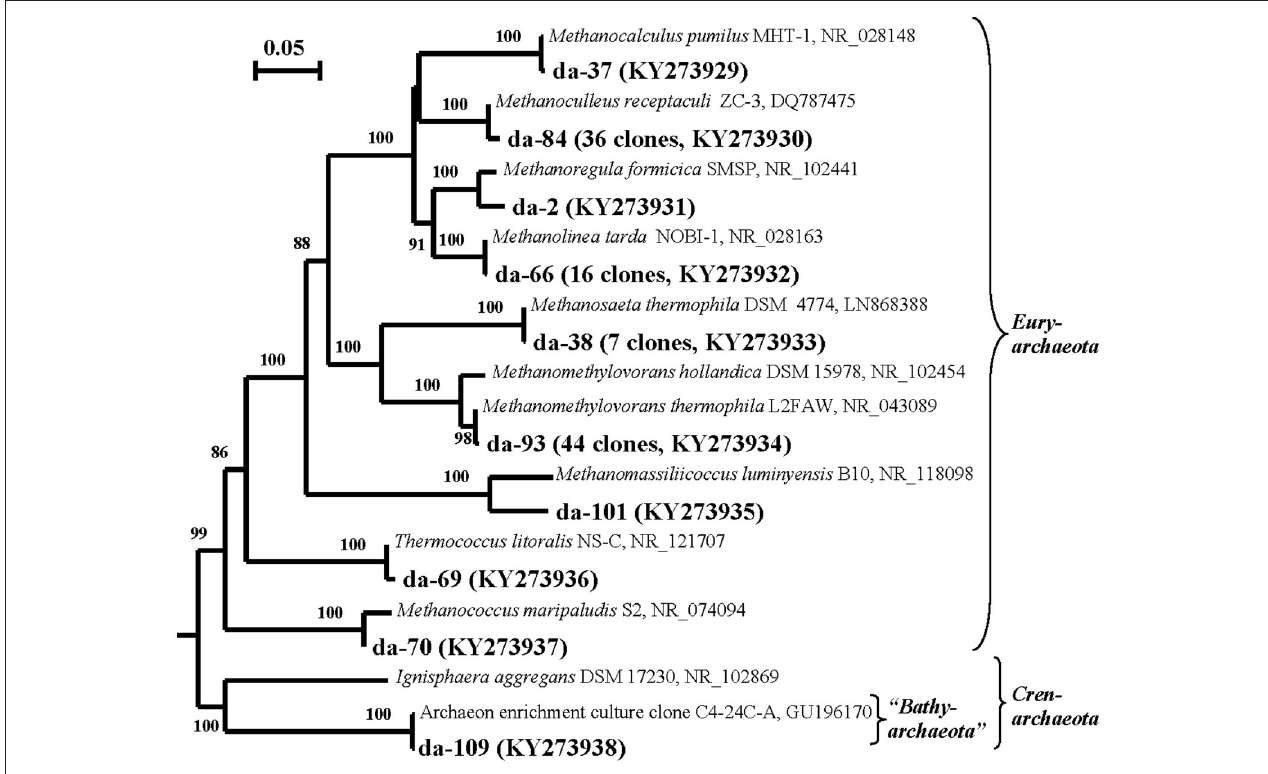
FIGURE 2 | Phylogenetic neighbor-joining tree constructed on the basis of analysis of the 16S rRNA gene sequences of Archaea revealed in the DNA-derived clone library of formation water from near-bottom zone of injection well 1098-8 m 3 sampled in December 2006 from the Kongdian bed. Designation: DA means DNA-based library of Archaea clones (115 clones). Scale bars show five (0.05) nucleotide substitution per 100 nucleotide base pairs. The numerals at the branching points show the significance of the branching order as determined by bootstrap analysis of 100 alternative trees (only bootstrap values above 85% were considered